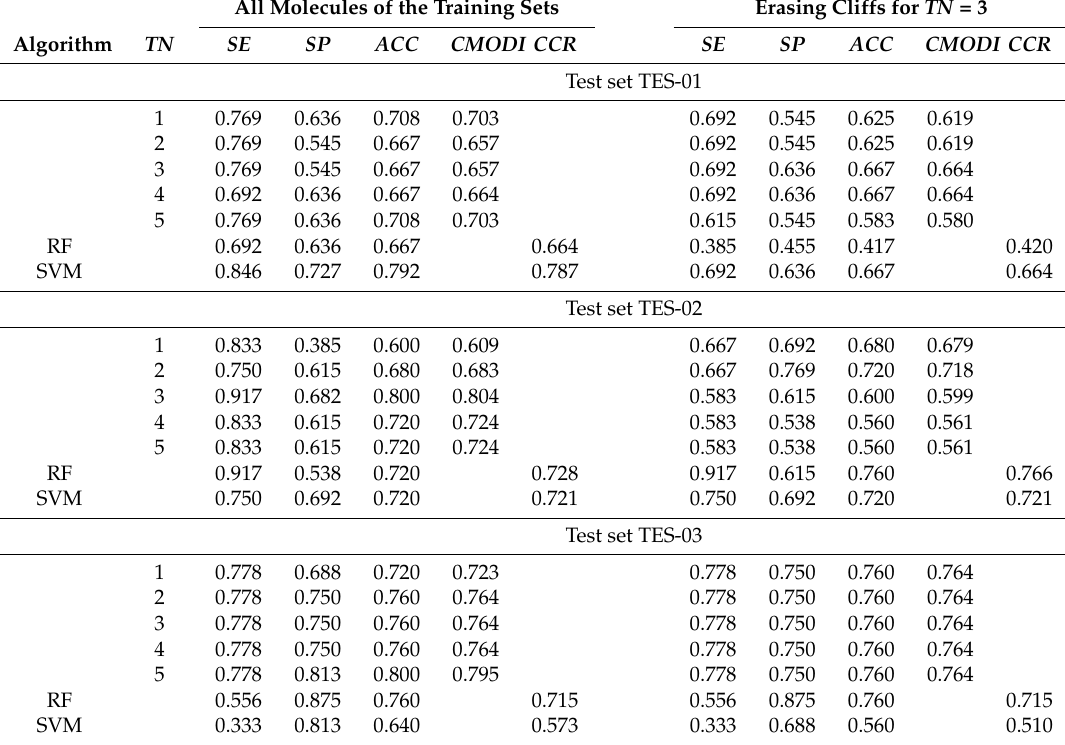
Table 5. Results of the MRP4 predictions using CMODI for different values of TN and the algorithms for the three whole training sets and the training sets erasing the activity cliffs detected for TN = 3. All Molecules of the Training Sets Erasing Cliffs for TN =